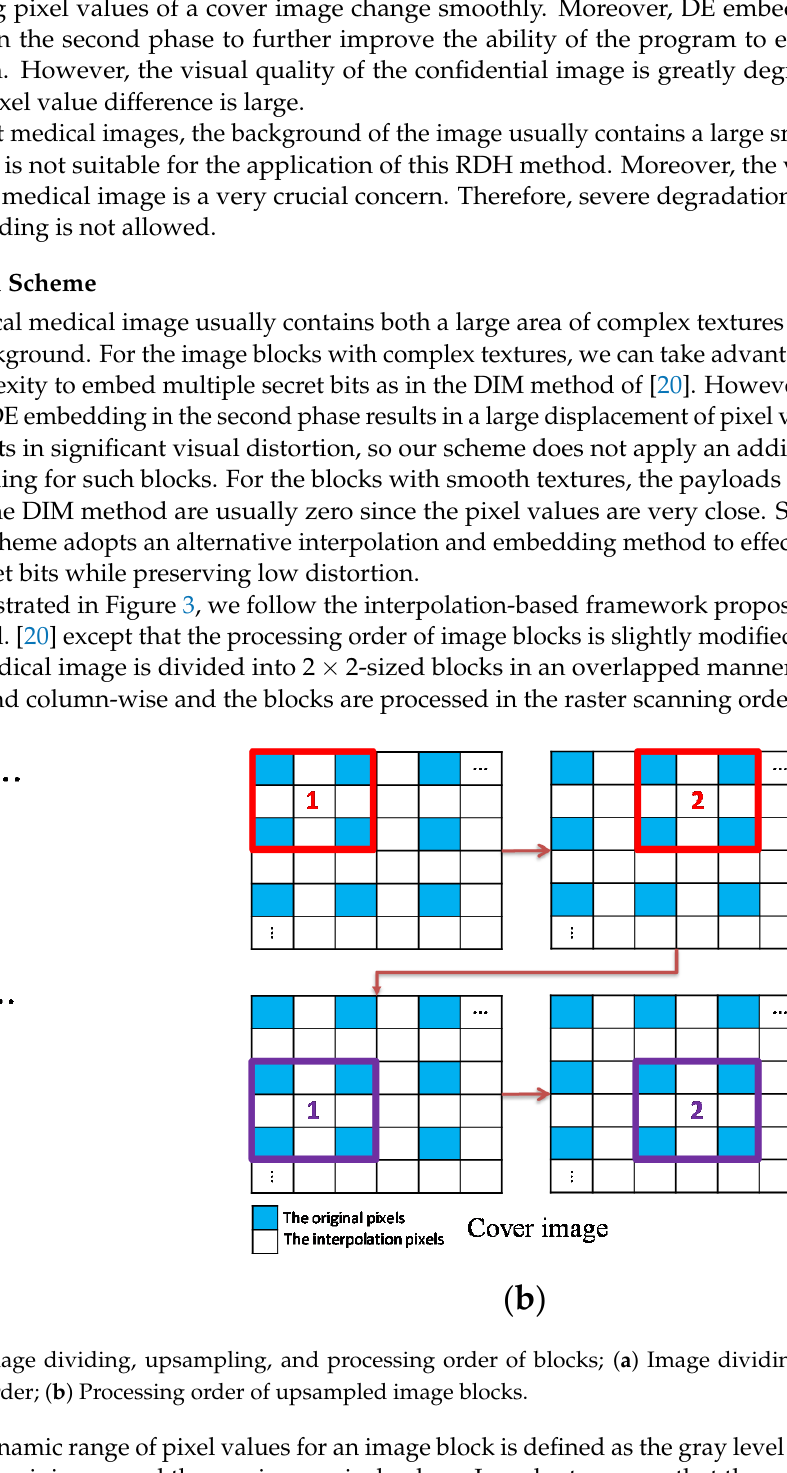
Figure 4. An example of pixel block classification. Algorithm 1 Image Upsampling and Block Classification Input: Original cover image 𝕆𝕀 -sized ℳ × 𝒩 , threshold value 𝒯 . Output: Vacated cover image ℂ -sized (2ℳ − 1) × (2𝒩 − 1) . Step 1: Upsample the ℳ × 𝒩 -sized image 𝕆𝕀 by zero-interlacing to obtain a (2ℳ − 1) × (2𝒩 − 1) -sized image ℂ𝕀 , whose values are given by ℂ(ℊ, 𝒽) = (cid:3420)𝕆𝕀(ℊ + 1)/2, (𝒽 + 1)/2), ℊ, 𝒽 ∈ odd, 0, otherwise. (9) Step 2: Image 𝕆𝕀 is divided into overlapped 2 × 2 pixel blocks given by 𝔹(𝓈, 𝓉) = 𝕆𝕀(𝓈: 𝓈 + 1, 𝓉: 𝓉 + 1), 1 < 𝓈 < (ℳ − 1), 1 < 𝓉 < (𝒩 − 1). (10) Step 3: The dynamic range 𝑝 (cid:3005)(cid:3019) of each block 𝔹(𝓈, 𝓉) is calculated by 𝑝 (cid:3040)(cid:3028)(cid:3051) = max (cid:4668)𝔹(𝓈, 𝓉)(cid:4669) = max(cid:4668)𝕆𝕀(𝓈: 𝓈 + 1, 𝓉: 𝓉 + 1)(cid:4669), 𝑝 (cid:3040)(cid:3036)(cid:3041) = min (cid:4668)𝔹(𝓈, 𝓉)(cid:4669) = min(cid:4668)𝕆𝕀(𝓈: 𝓈 + 1, 𝓉: 𝓉 + 1)(cid:4669),